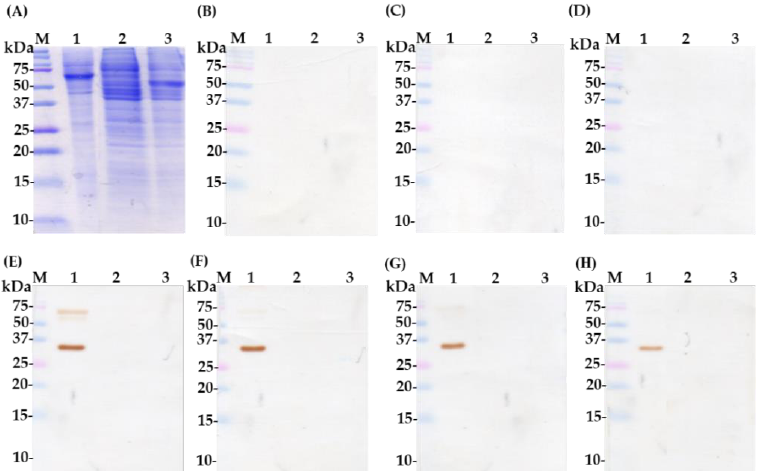
Figure 2. Characterization of immunoglobulin yolk-binding protein by Western blot. SDS-PAGE displaying CA16-infected lysate (lane 1), non-infected (RD cells) lysate (lane 2), and BSA (lane 3) stained with Coomassie blue dye; lane M: protein marker ( A ). The samples were transferred onto PVDF membranes and detected with pre-vaccination IgY ( B ); 1st-vaccination IgY ( C ); 3rd-vaccination IgY ( D ); 5th-vaccination IgY ( E ); 6th-vaccination IgY ( F ); 7th-vaccination IgY ( G ); and 8th-vaccination IgY ( H ) antibodies at a dilution of 1:3000. The complex was then revealed by HRP-conjugated donkey anti-chicken IgY antibodies at a dilution of 1:10,000. BSA and non-infected lysate were used as negative antigen controls.